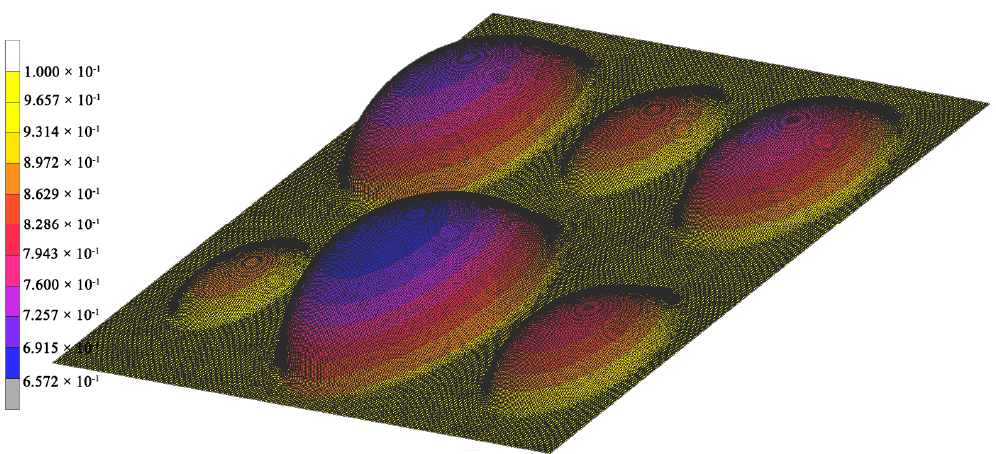
Figure 5. Thickness distribution after multi-dome forming FE simulation. Table 3. Deviations between FE-simulations and multi-dome tests